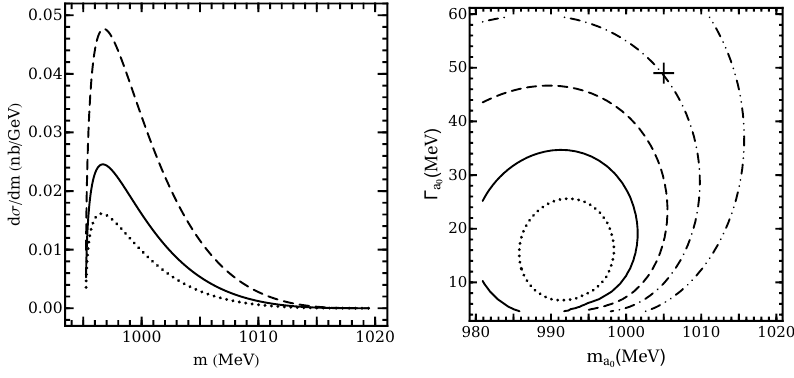
Figure 3. Left panel: di ff erential cross-section for the reaction e + e − → K 0 ¯ K 0 γ as a function of the K 0 ¯ K 0 e ff ective mass. The curves are labelled as in the left panel of Fig. 2. Right panel: contours of the branching fraction Br for the decay φ → K 0 ¯ K 0 γ in the complex plane of the a 0 (980) pole position: m a is the resonance mass and Γ a is its width. The solid curve corresponds to the KLOE upper 0 (980) 0 (980) limit Br = 1 . 9 · 10 − 8 , the dotted one to Br = 1 . 0 · 10 − 8 , the dashed curve to Br = 3 . 0 · 10 − 8 , the dashed- dotted one to Br = 4 . 0 · 10 − 8 , and the dashed- double dotted one to Br = 5 . 0 · 10 − 8 . The cross indicates the a 0 (980) resonance position on sheet ( − + ) found in Ref.